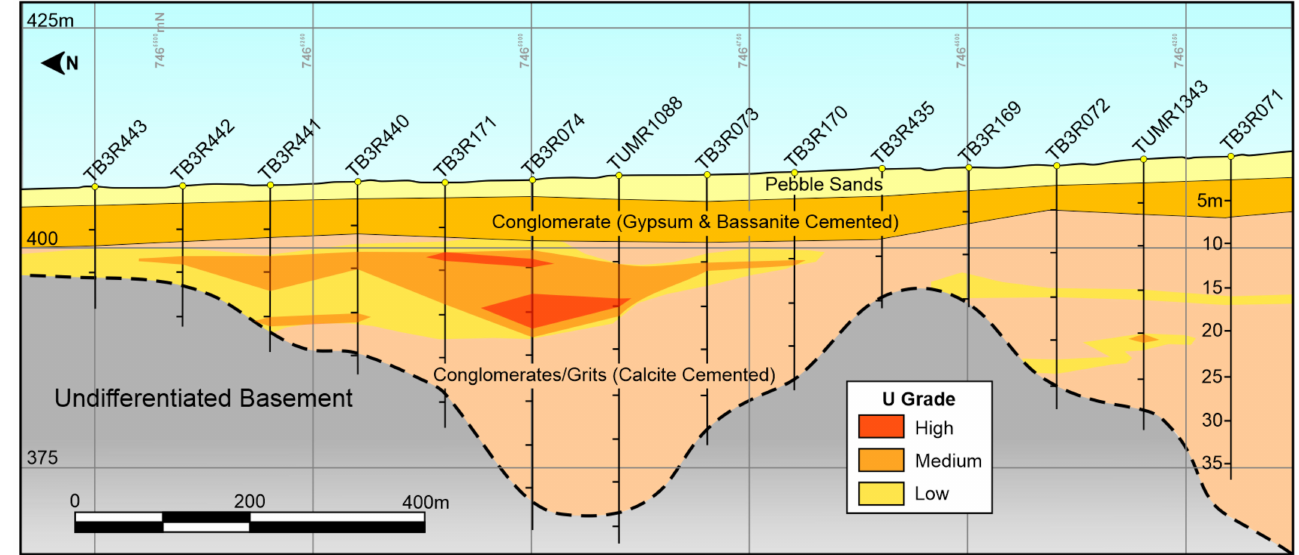
Figure 4. Typical cross section from Tumas